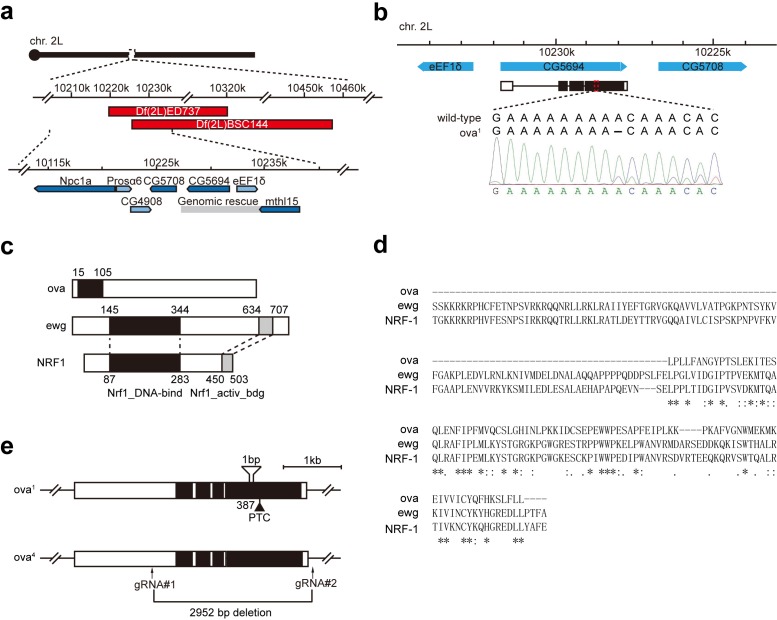
Ova is allelic to CG5694.(a) Top, a schematic drawing of mapping results of ova1 allele using deficiency kit. Two small deficiencies, Df(2L)ED737 and Df(2L)BSC144, both failed to complement ova1 (Figure 1—figure supplement 1a). Bottom, analysis of the overlapping regions of these deficiencies implicated five candidate genes. Gray box, ova genomic rescue fragment. (b) DNA sequencing revealed a nucleotic deletion in the coding region of CG5694. (c) Schematic drawings of Ova, Drosophila Ewg-PA, and mouse NRF-1 PA proteins. Black box, Nrf1 DNA-binding domain. Grey box, Nrf1 activator-binding domain. (d) Multiple sequence alignments of Nrf1-binding domain of Ova, Ewg, and NRF-1 by Clustal Omega. (e) Schematic drawings of two CG5694/ova alleles, ova1, and ova4. ova1 is a deletion allele generated using CRISPR-Cas9.